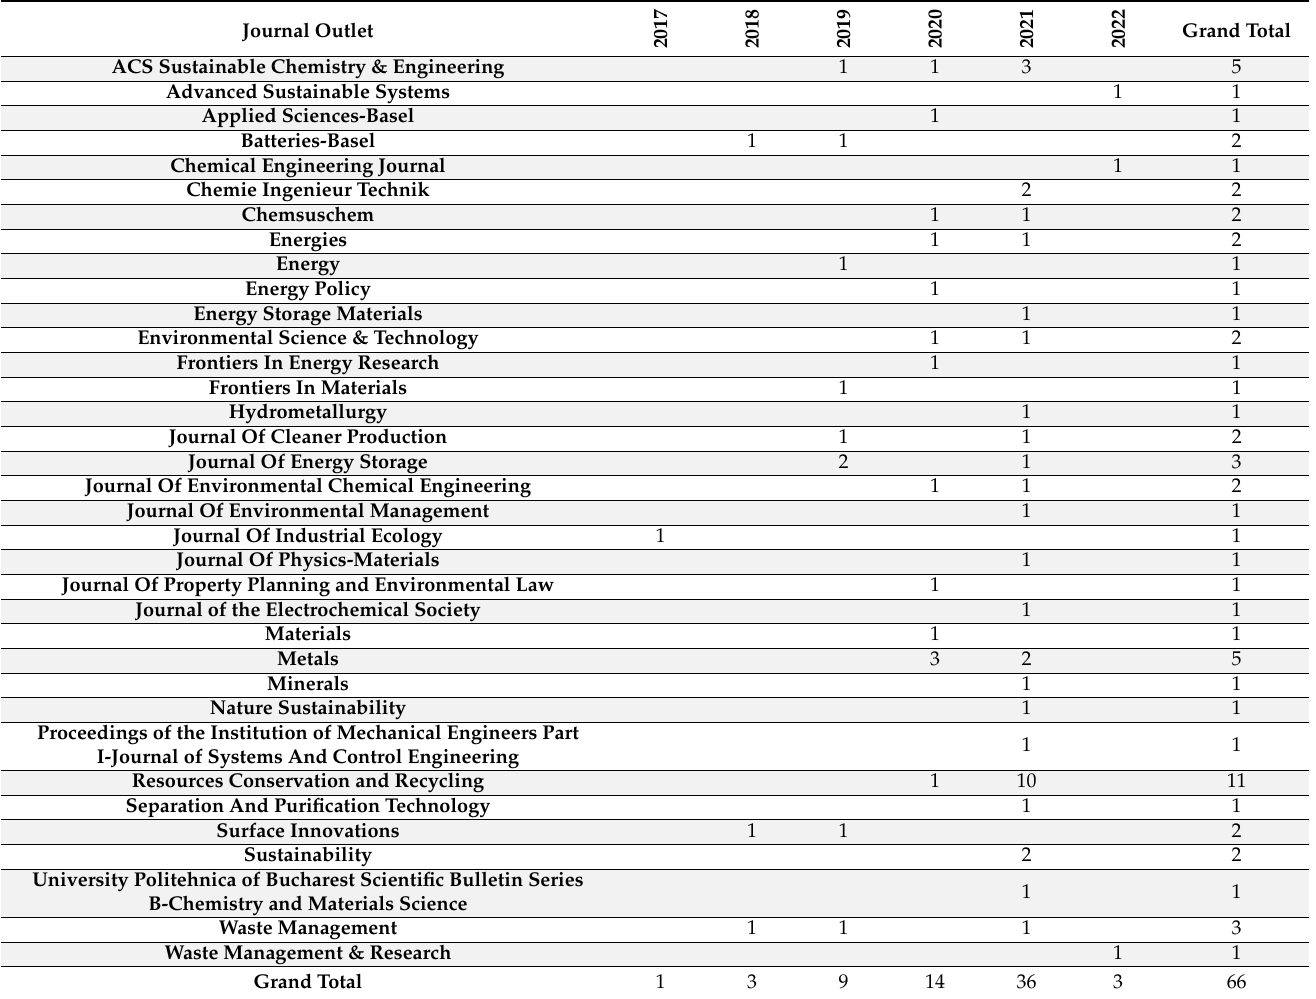
Table 2. Number of publications by year and journal outlets (Data retrieved from Web of Science